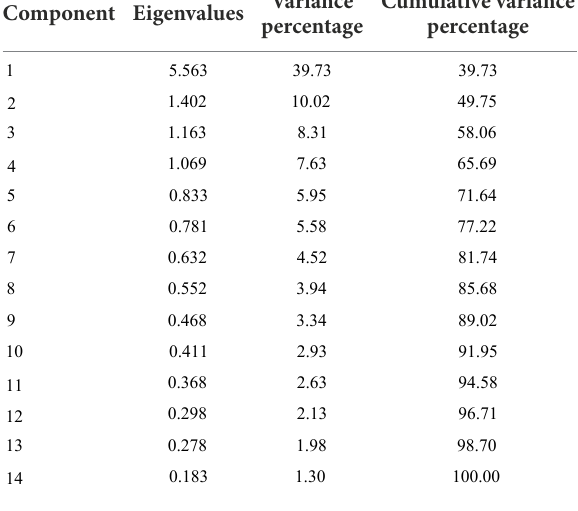
TABLE 5 Variance